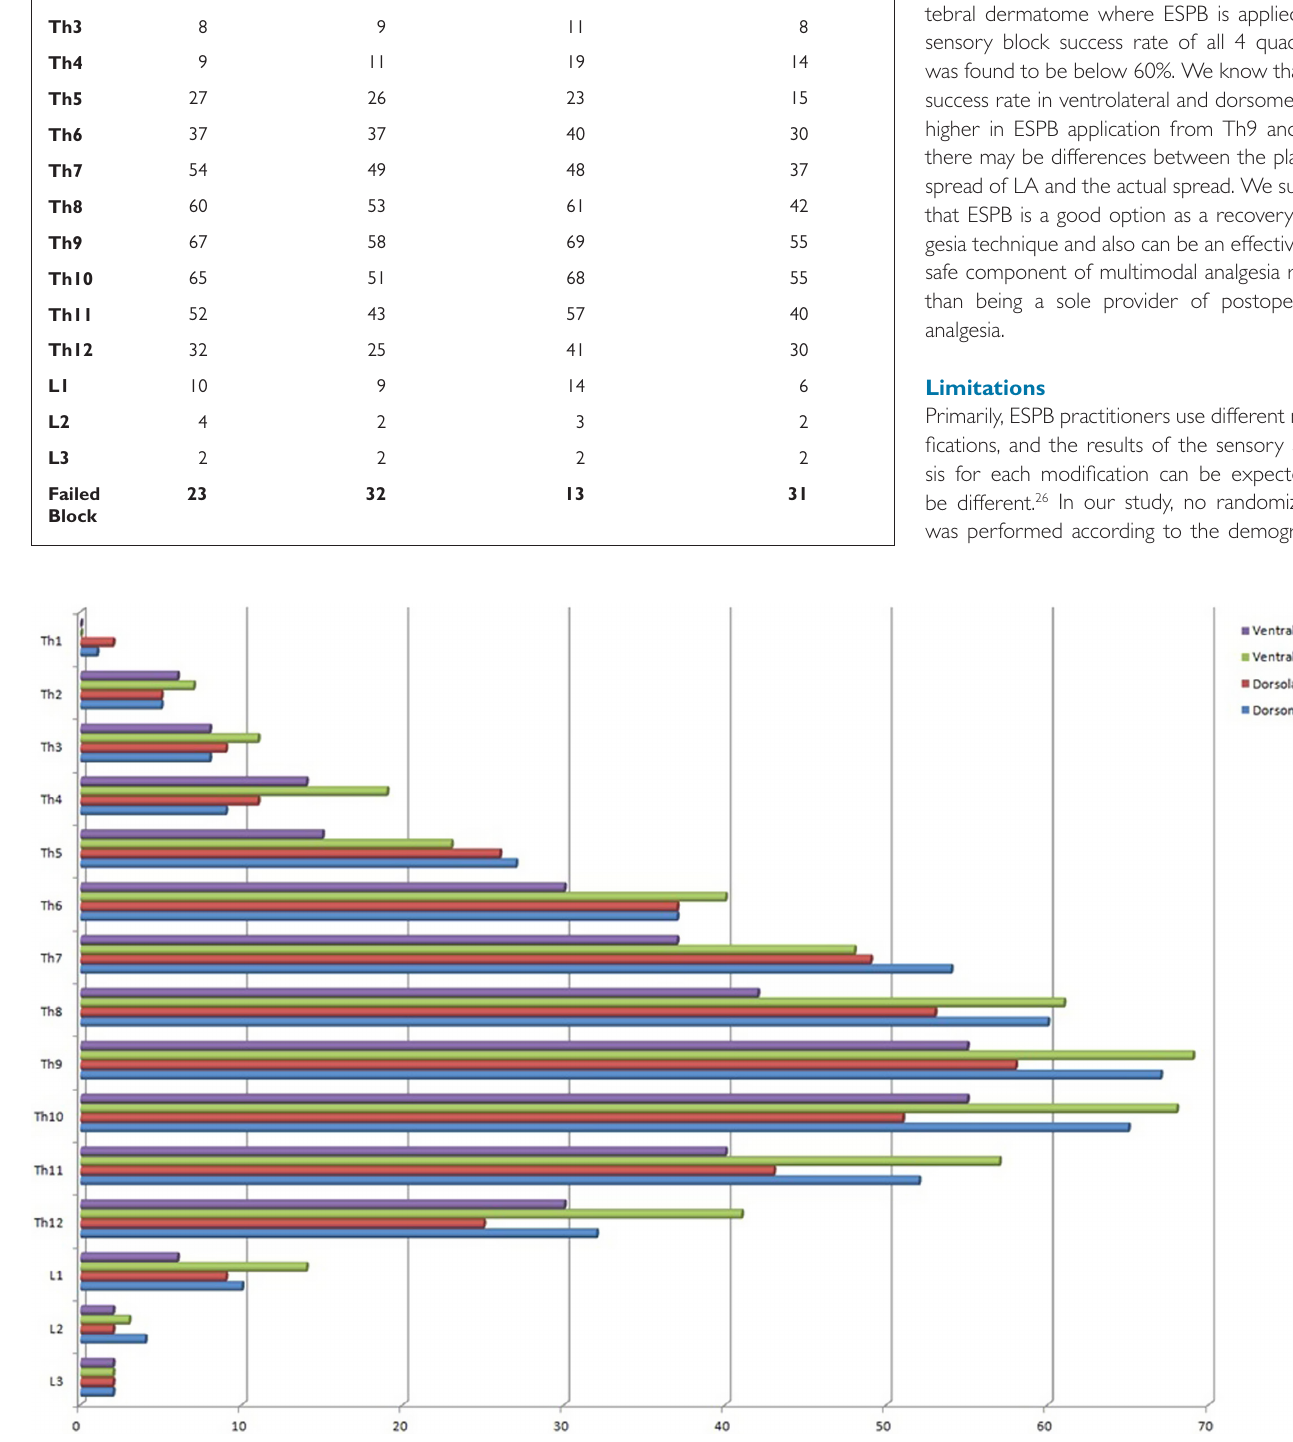
Figure 2. Quadrant involvement of sensorial block distribution of the ESPB at Th9 level. The horizontal axis shows the percentage of the number of the patients who had dermatomal block. The vertical axis shows the thoracal and lumbar dermatomes analyzed with pinprick tests. ESPB, erector spinae plane